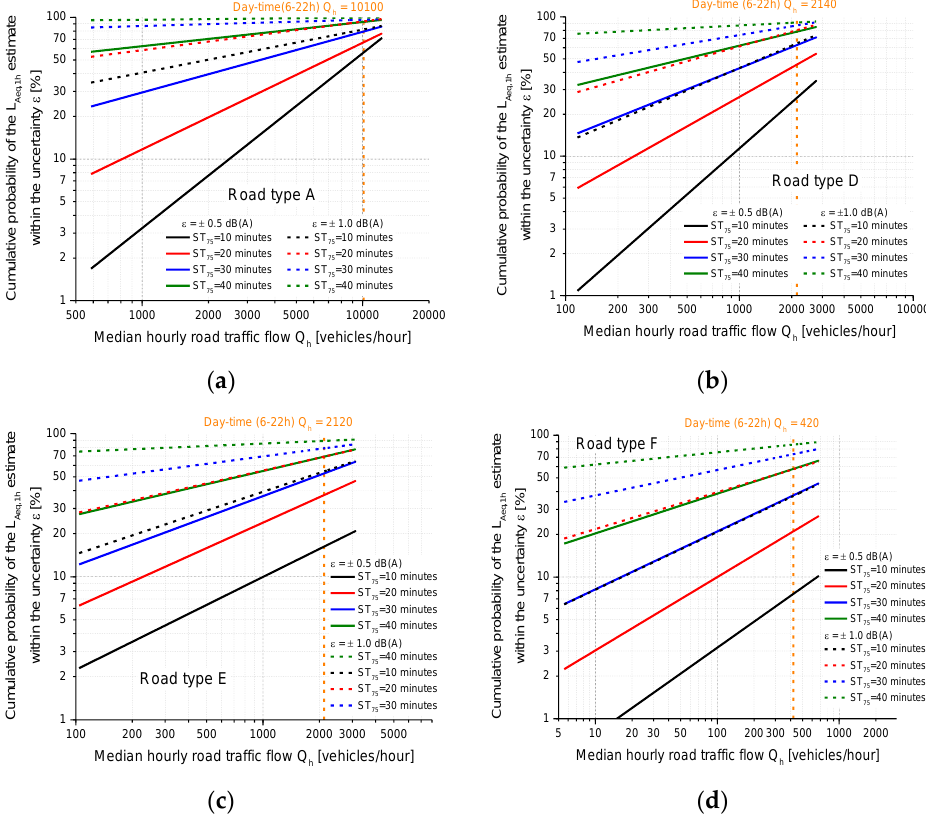
Figure 8. Cumulative probability P ST75, ε that a preset ST 75 value provides an estimate of L Aeq,1h within a fixed uncertainty ε for each of the four road types (( a – d )-letters refer to road types A, D, E, F) versus the median hourly road traffic flow Q h .